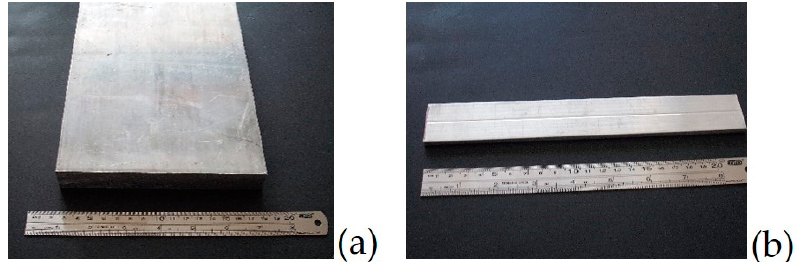
Figure 1. Foamable precursor materials made of aluminum alloys and titanium hydride with 160 × 20 mm ( a ) and 20 mm × 5 mm ( b ) in cross-section. Table 1. Properties of the powders.